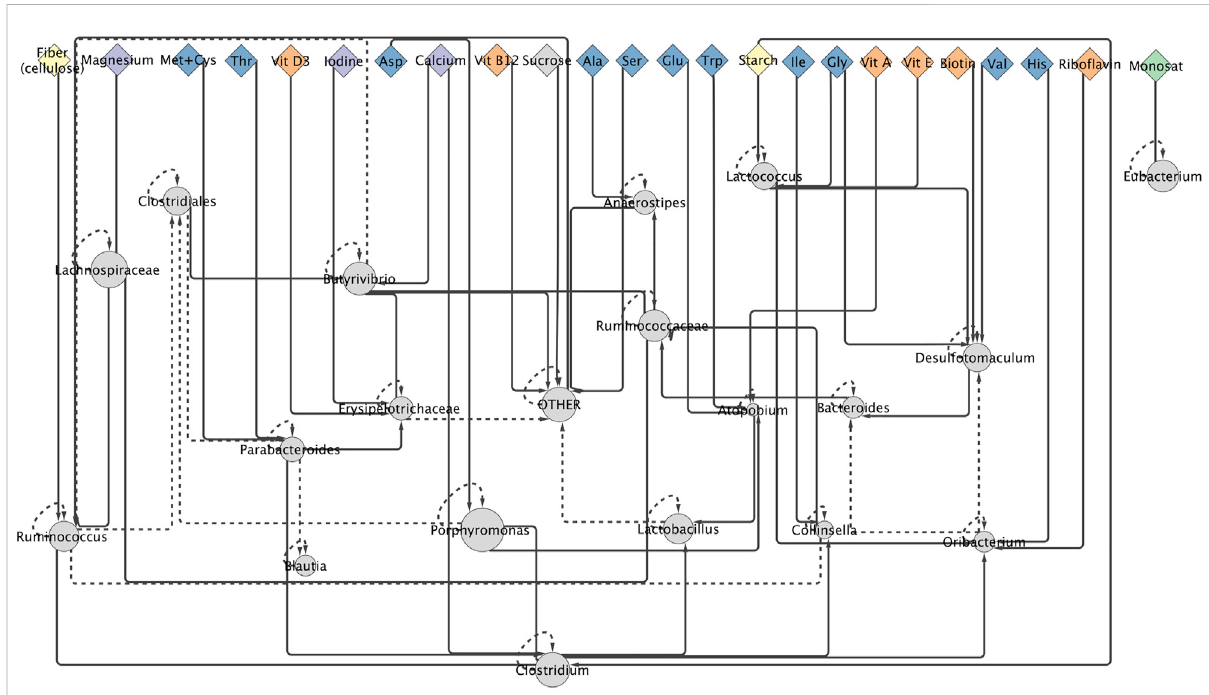
FIGURE 5 Results of in silico microbiome transplant experiment. The in silico results of the microbiome experiment, in which mice with a “ Lean ” or “ Obese ” starting microbiome are fed a Low Fat (LF) or High Fat (HF) diet. Y-axis is the predicted obesogenesis of host-microbiome-diet interactions with larger values indicated increased